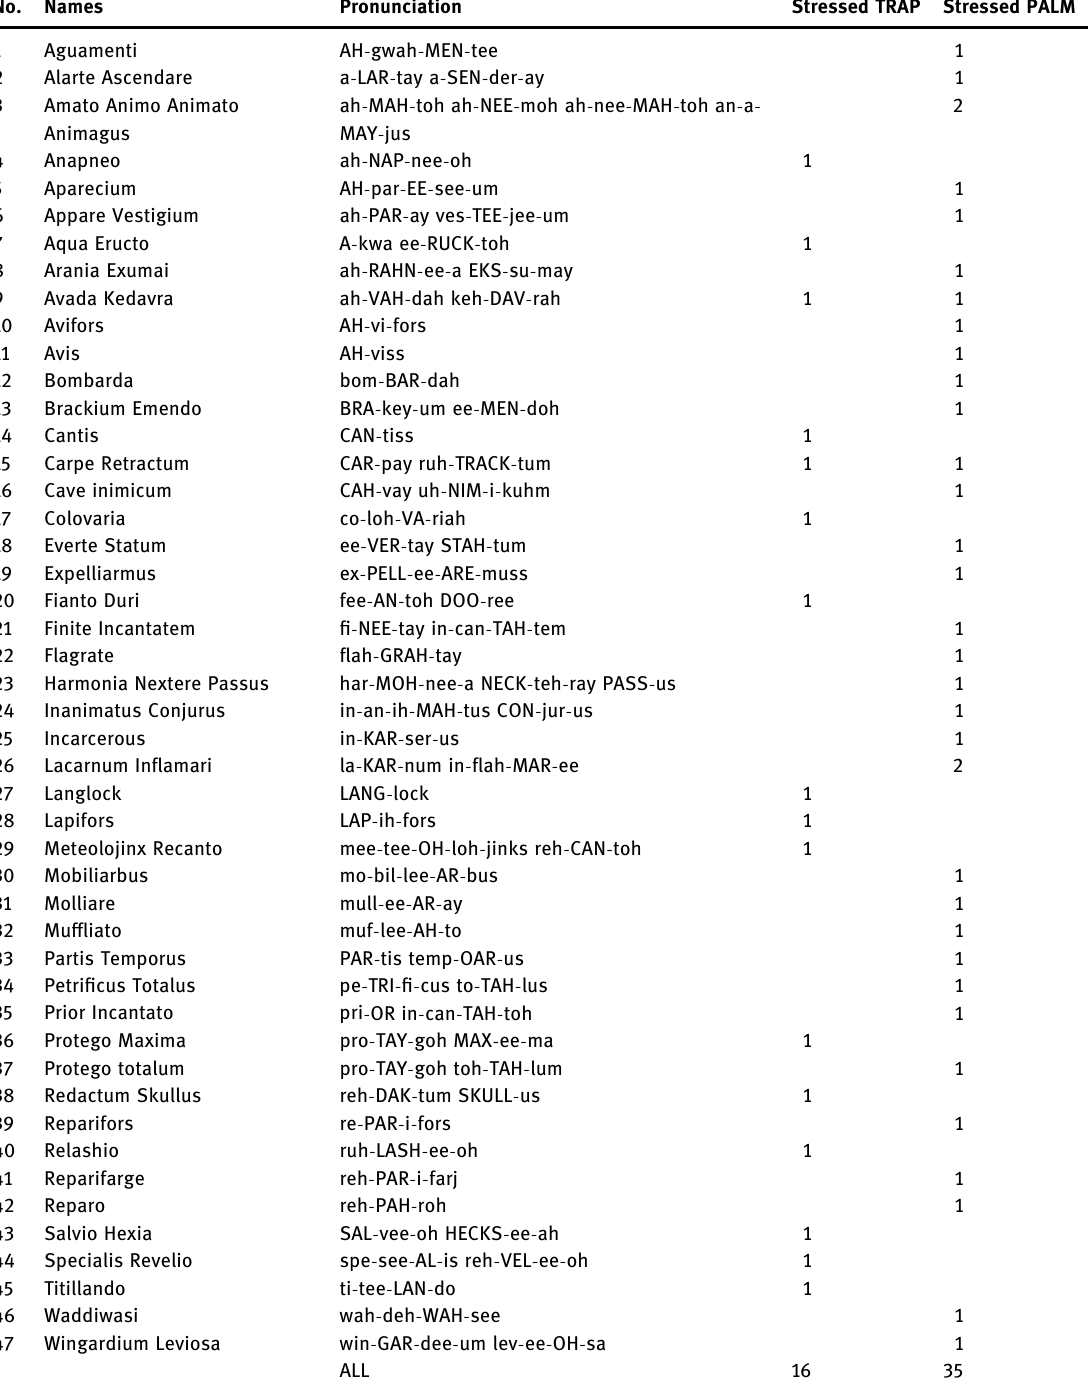
Table 5: Spells that contain stressed low vowels No.